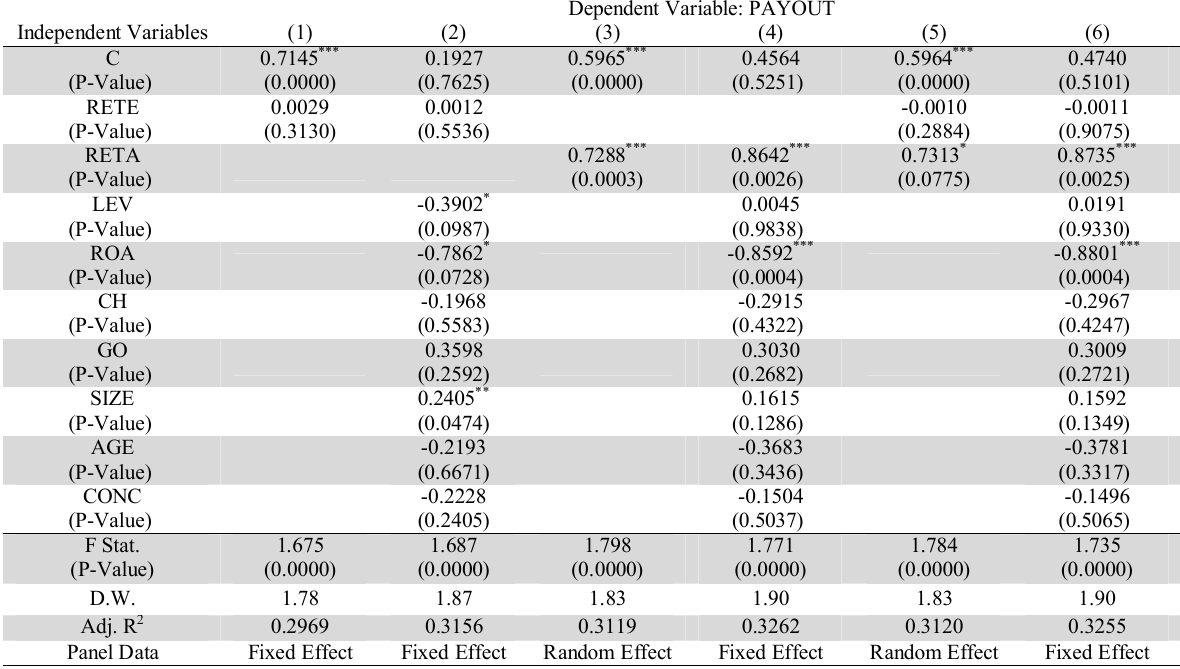
The summary of regression